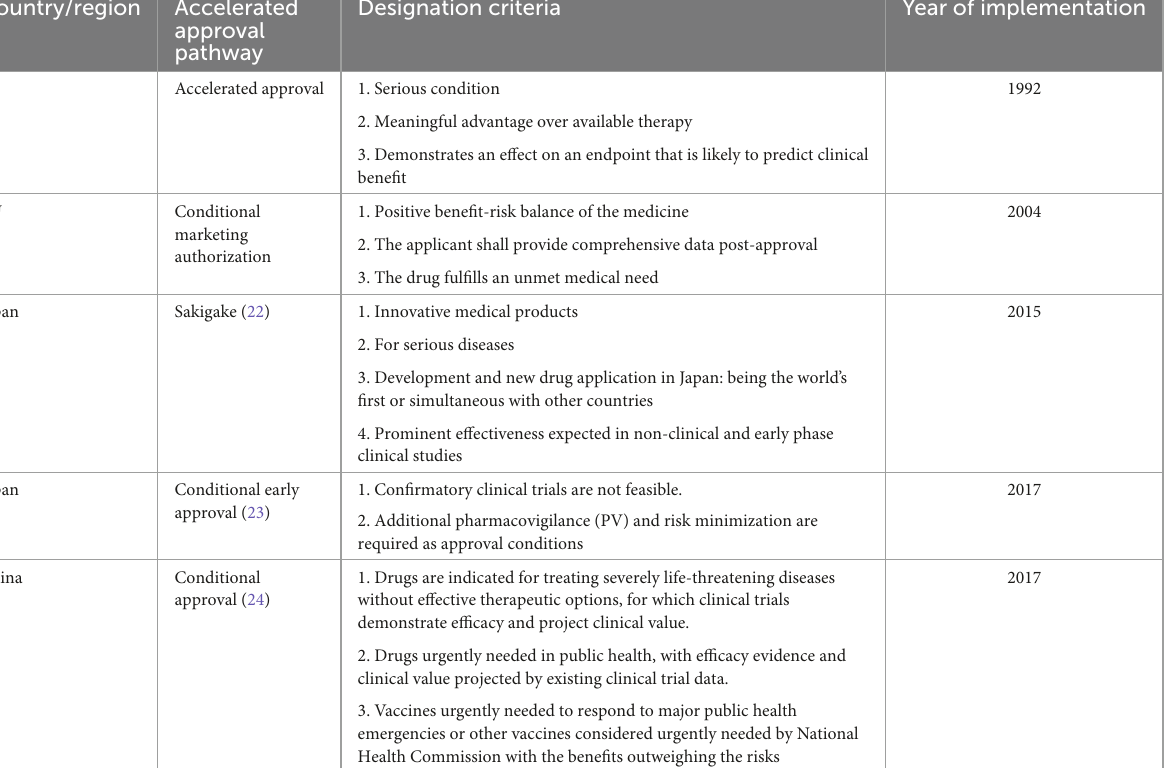
TABLE 2 Summary of drug accelerated approval pathway in the US, EU, Japan, and China.